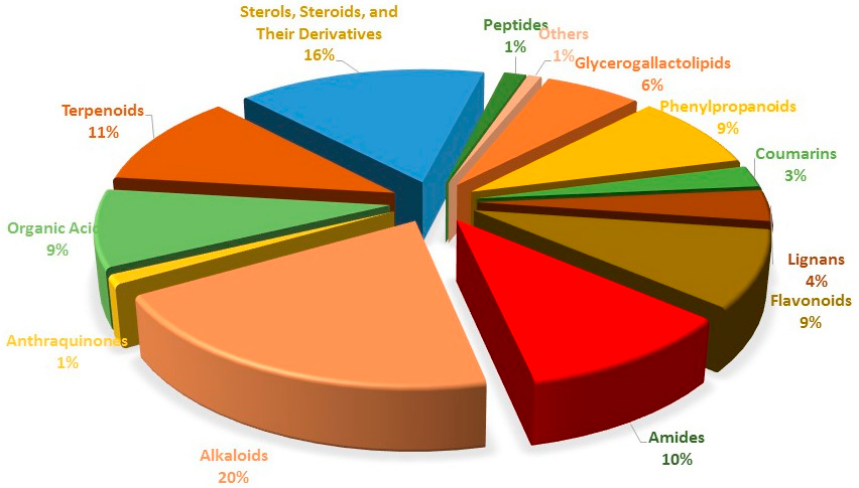
Figure 1. Different subtype comparison of the 355 constituents reported from Lycium genus.